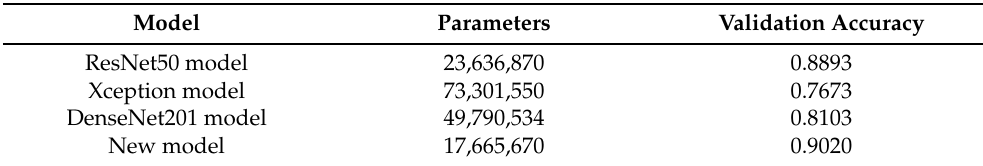
Table 2. Validation accuracy and the number of parameters of Intel images classification dataset performed with four different classification